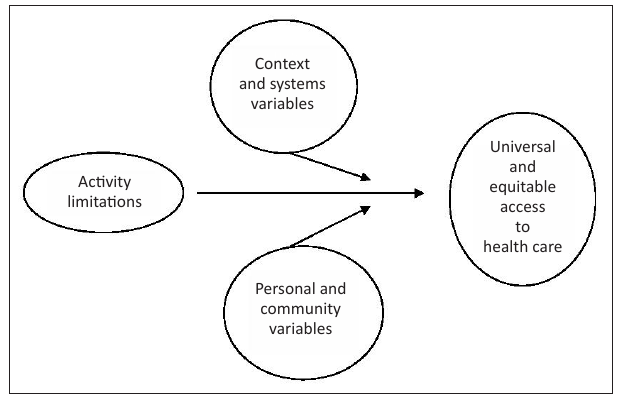
FIGURE 1: Schematic summary of the theoretical model on which EquitAble was